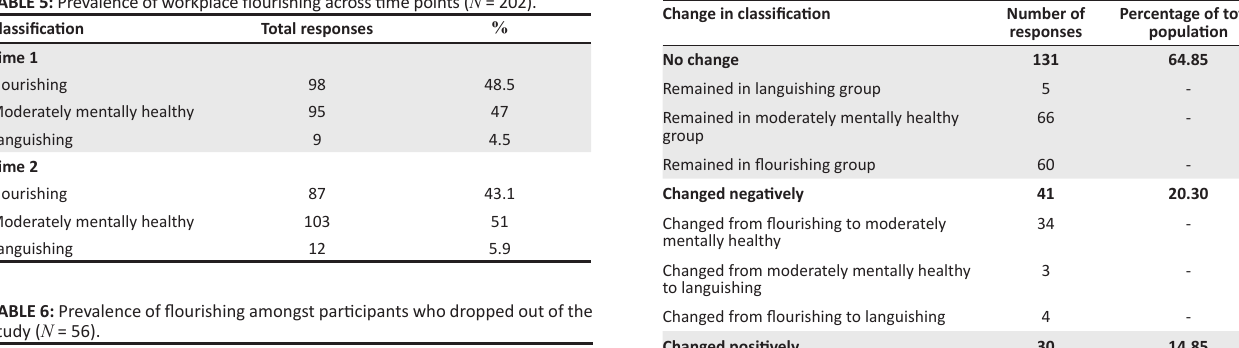
TABLE 7: Changes in classification over time ( N = 202)